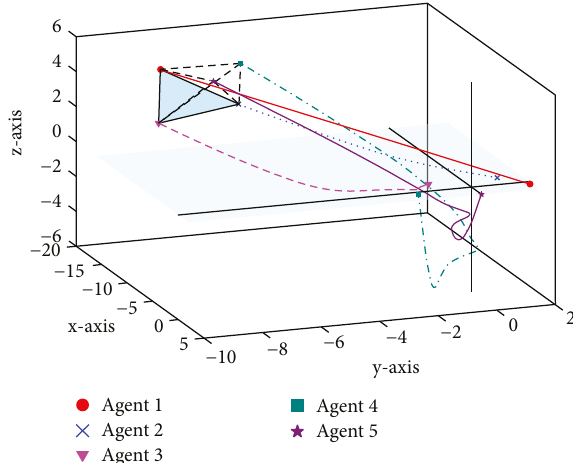
ν 4 and agent 5 Figure 5: Distance errors: agent ν Orientation 1.